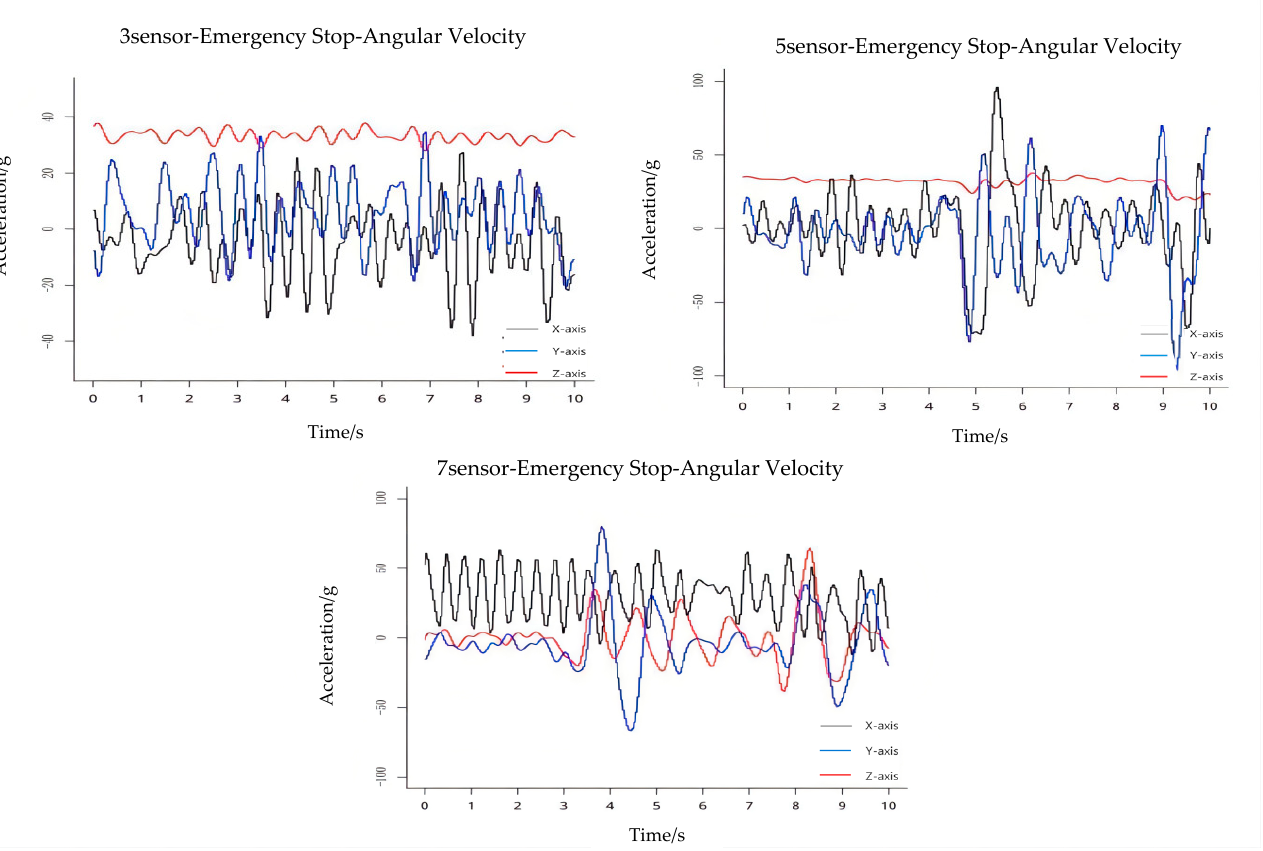
Figure 6. Angular velocity graph at the sudden stop.